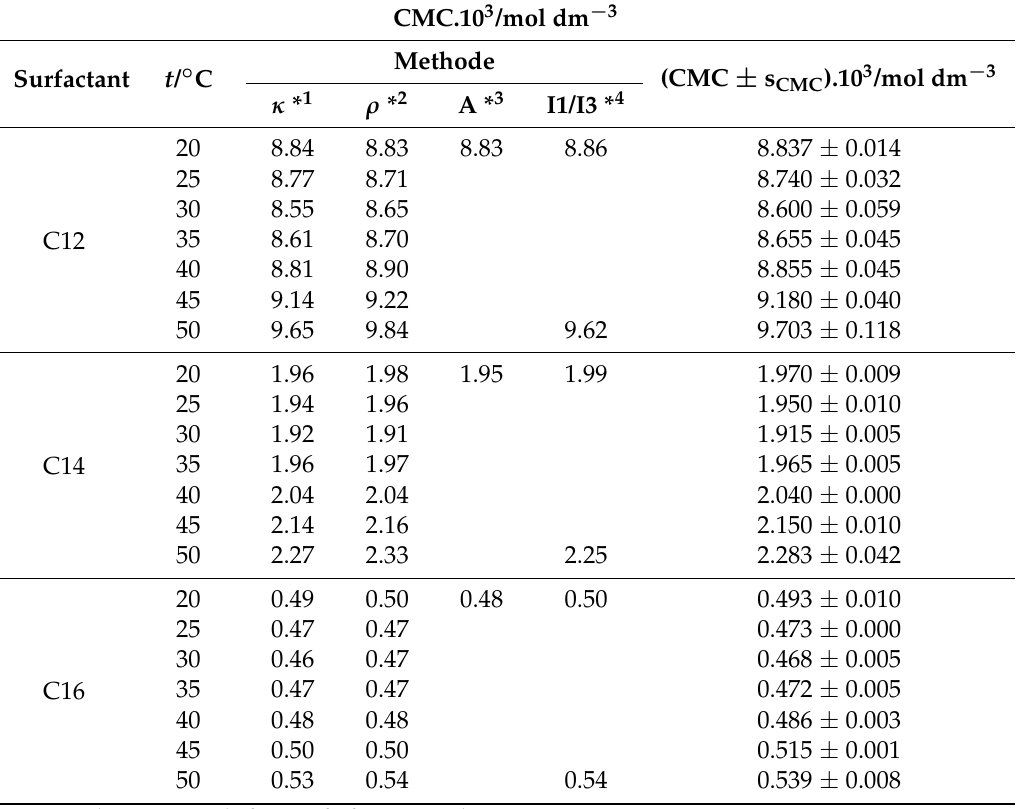
Table 1. Dependencies of critical micelle concentration (CMC) on the length of the alkyl chain and temperature of the studied surfactants, C12, C14, and C16, by using experimental methods, namely conductometry ( κ ) and densitometry ( ρ ) (20–50 ◦ C), spectrophotometry (A), and spectrofluorimetry (I1/I3) (25 ◦